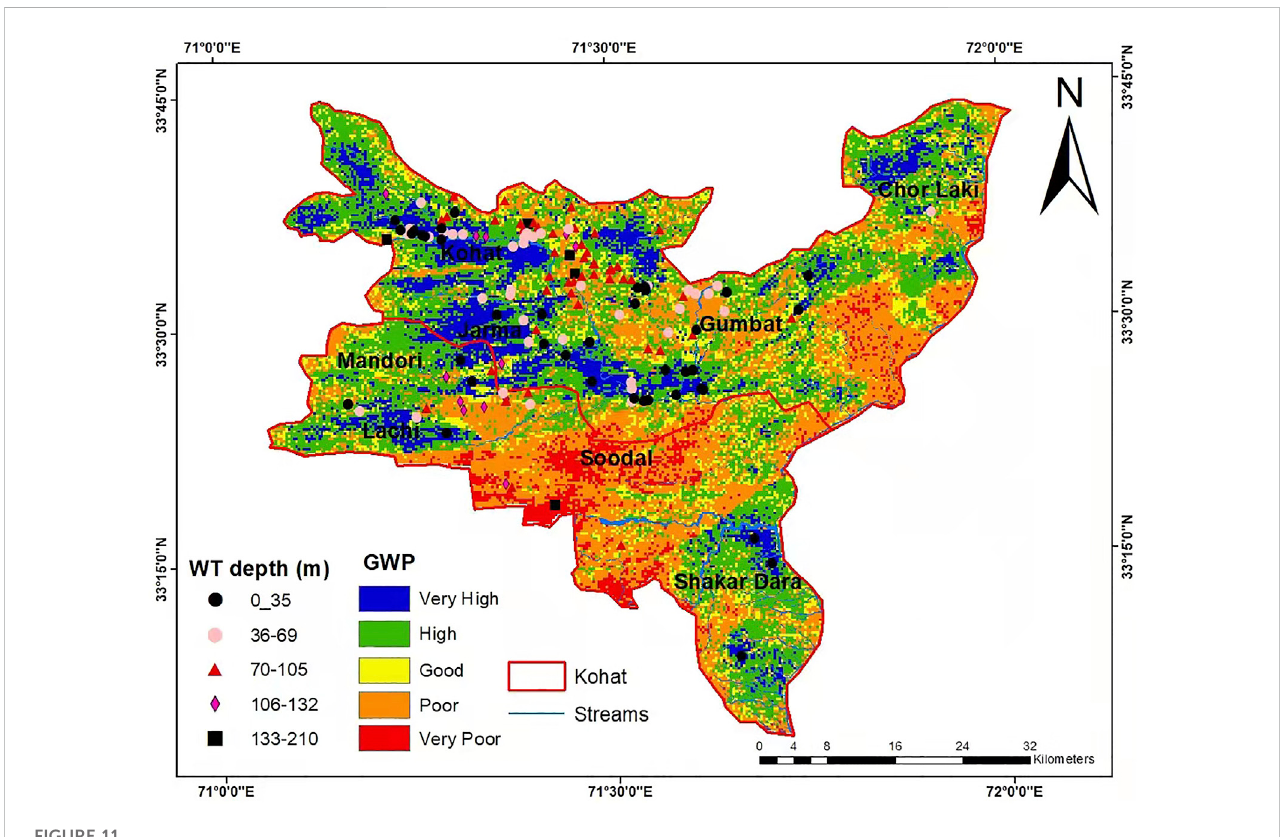
FIGURE 11 Map representing GWP